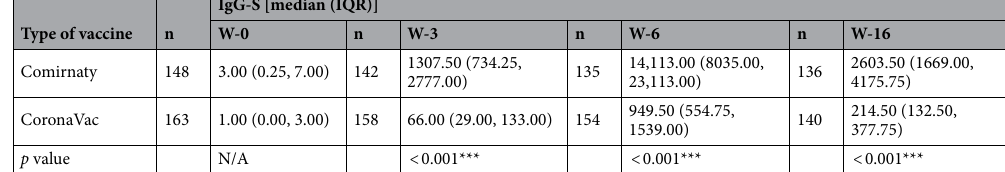
Table 3. Median IgG-S antibody titers over time, based on the vaccine type. Samples (n) and interquartile ranges (IQRs) indicate the minimum and maximum values. p value was set according to the Mann–Whitney U test. W-0, Week zero; W-3, Week three; W-6, Week six; W-16, Week 16. * p < 0.05; ** p < 0.01; *** p < 0.001.